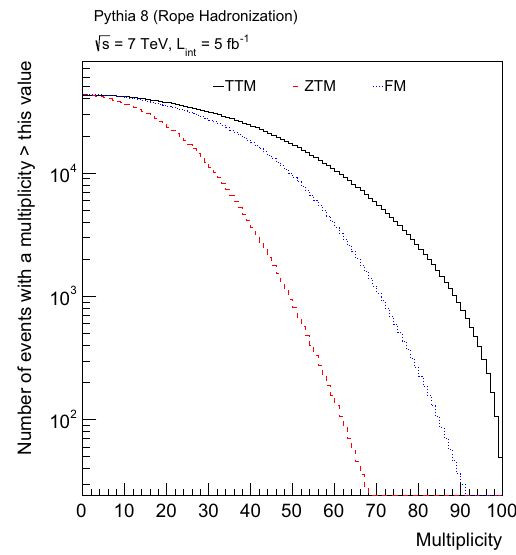
Fig. 1 Left: The number of expected Z + 1 jet events passing the selection cuts, in 5 fb − 1 , with a given multiplicity threshold defined by TTM, ZTM, or FM. Right: the number of events that pass a threshold on